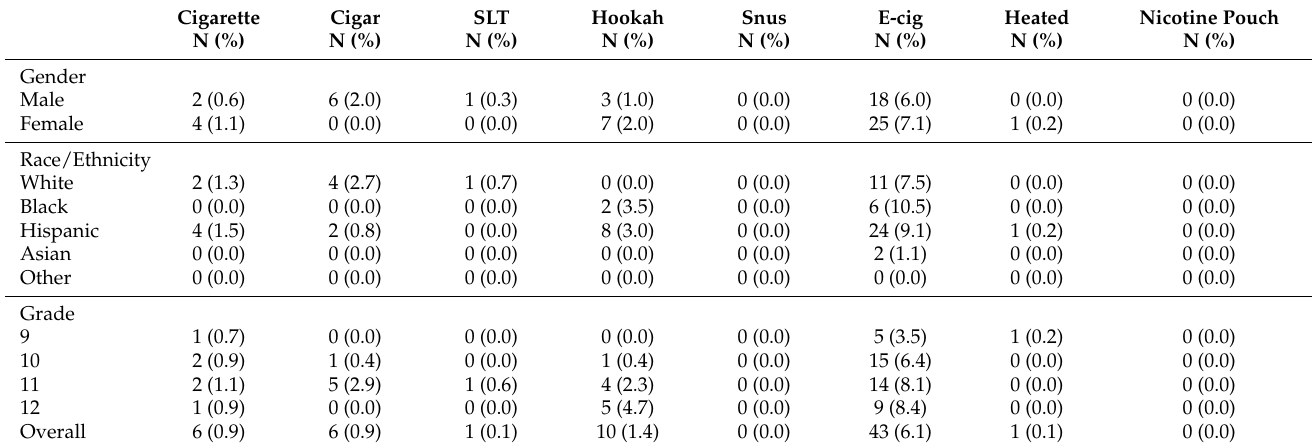
Table 3. Current (past 30 days) use of tobacco products, NJYTS 2021 (n =